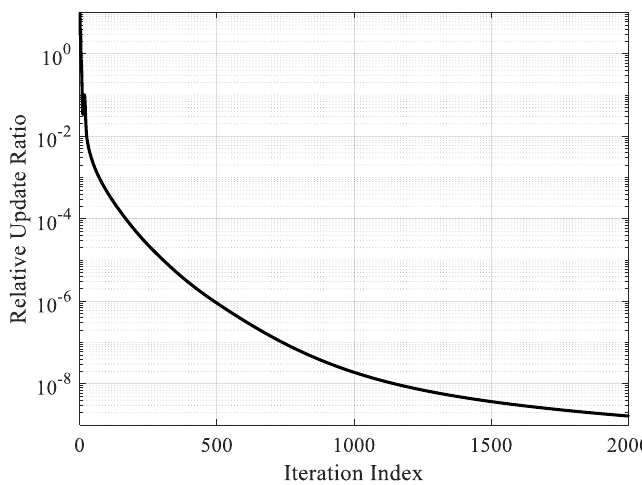
Figure 5. The convergence of the spatial spectrum iterative estimation process.